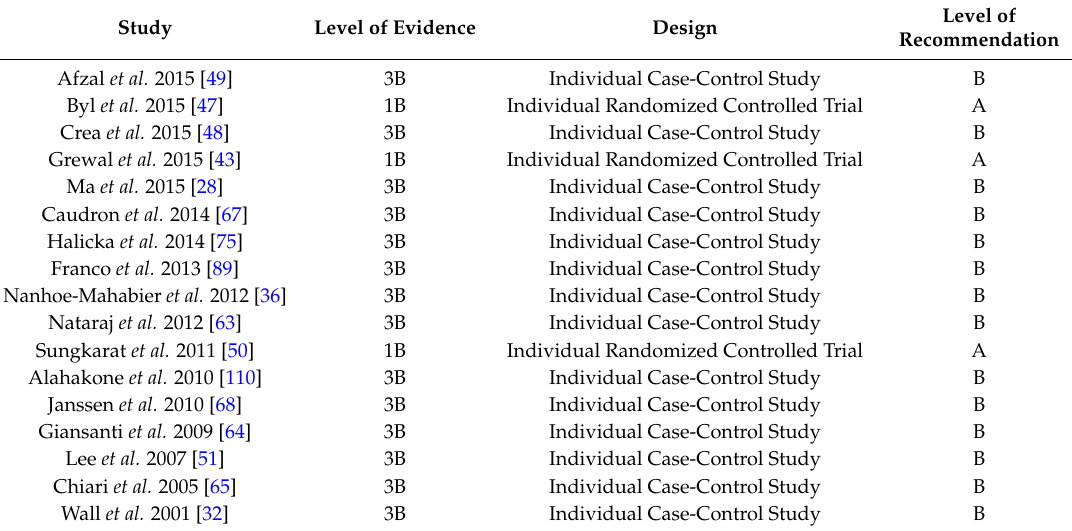
Table 5. Level of evidence and grade of recommendation ( n =